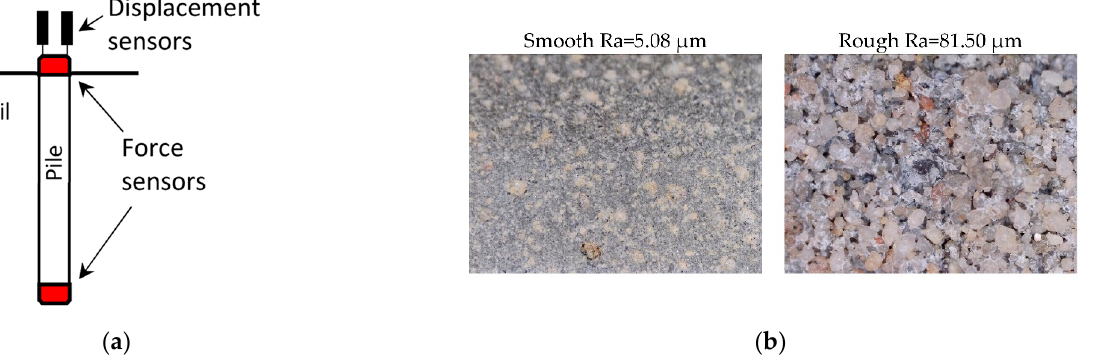
Figure 5. ( a ) Scheme of the instrumented pile. ( b ) Photo of different surfaces of piles.